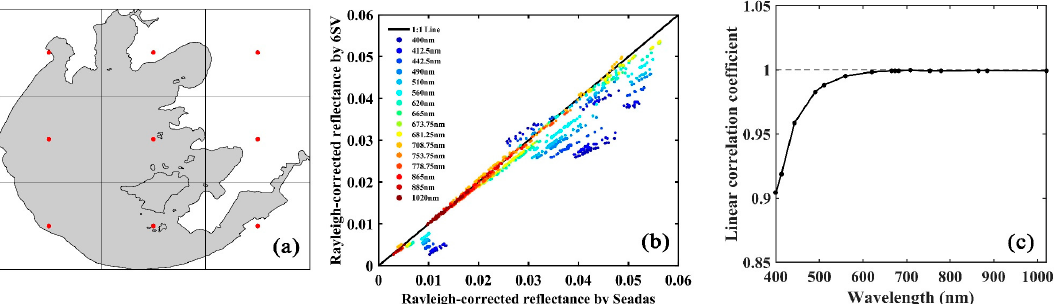
Figure 4. ( a ) The smallest rectangle containing the lake area was divided into several squares of the same size for SL05-1613 nm and SL06-2250 nm Rayleigh correction. The red dot represents the square center. ( b ) The scatter plot of Rayleigh corrected reflectance at in situ points by Seadas and 6SV, respectively. The solid line presents the 1:1 line and colored dots present the 16 selected OLCI bands from 400 nm to 1020 nm. ( c ) The linear correlation coefficient of results performed by Seadas and 6SV, which is close to 1 with the increasing wavelength.